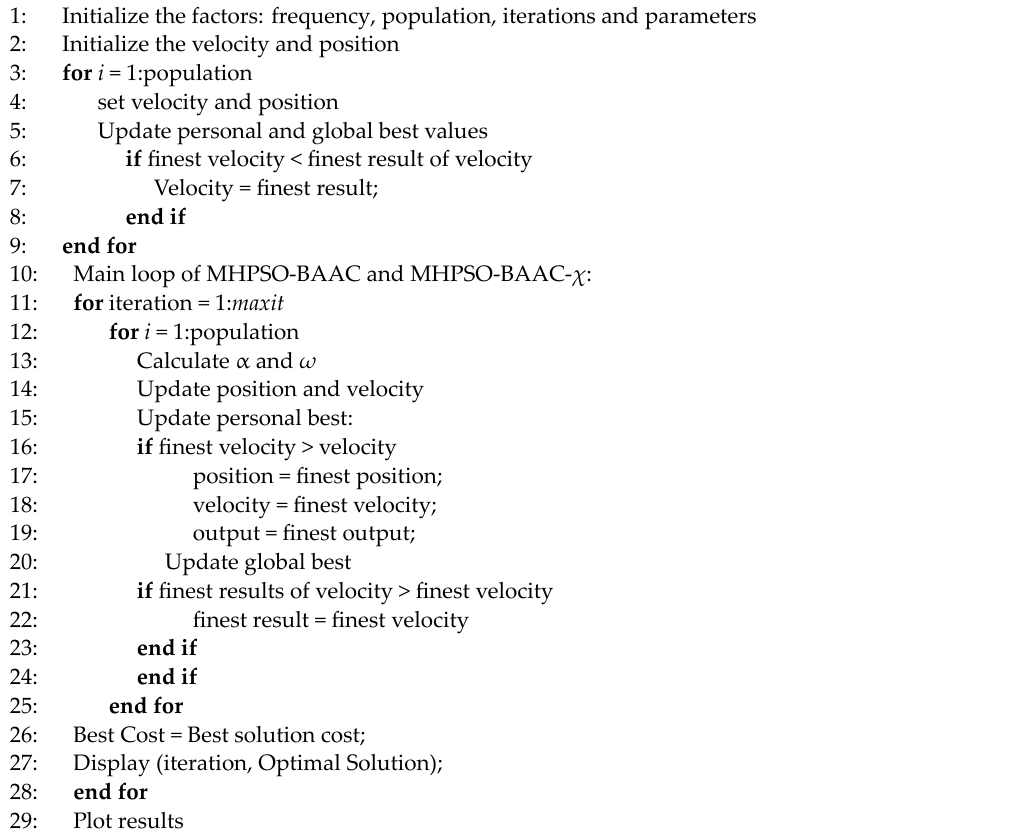
Algorithm 2. The MHPSO‑BAACs